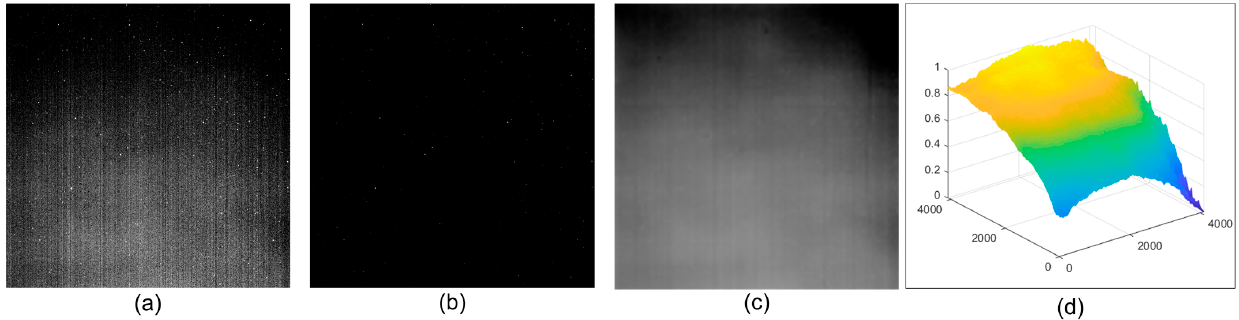
Figure 7. The results of removing inhomogeneous backgrounds using our method under a low elevation angle. ( a ) The captured image; ( b ) the corrected image; ( c ) the estimated background; ( d ) the grey-level distribution of ( c ).